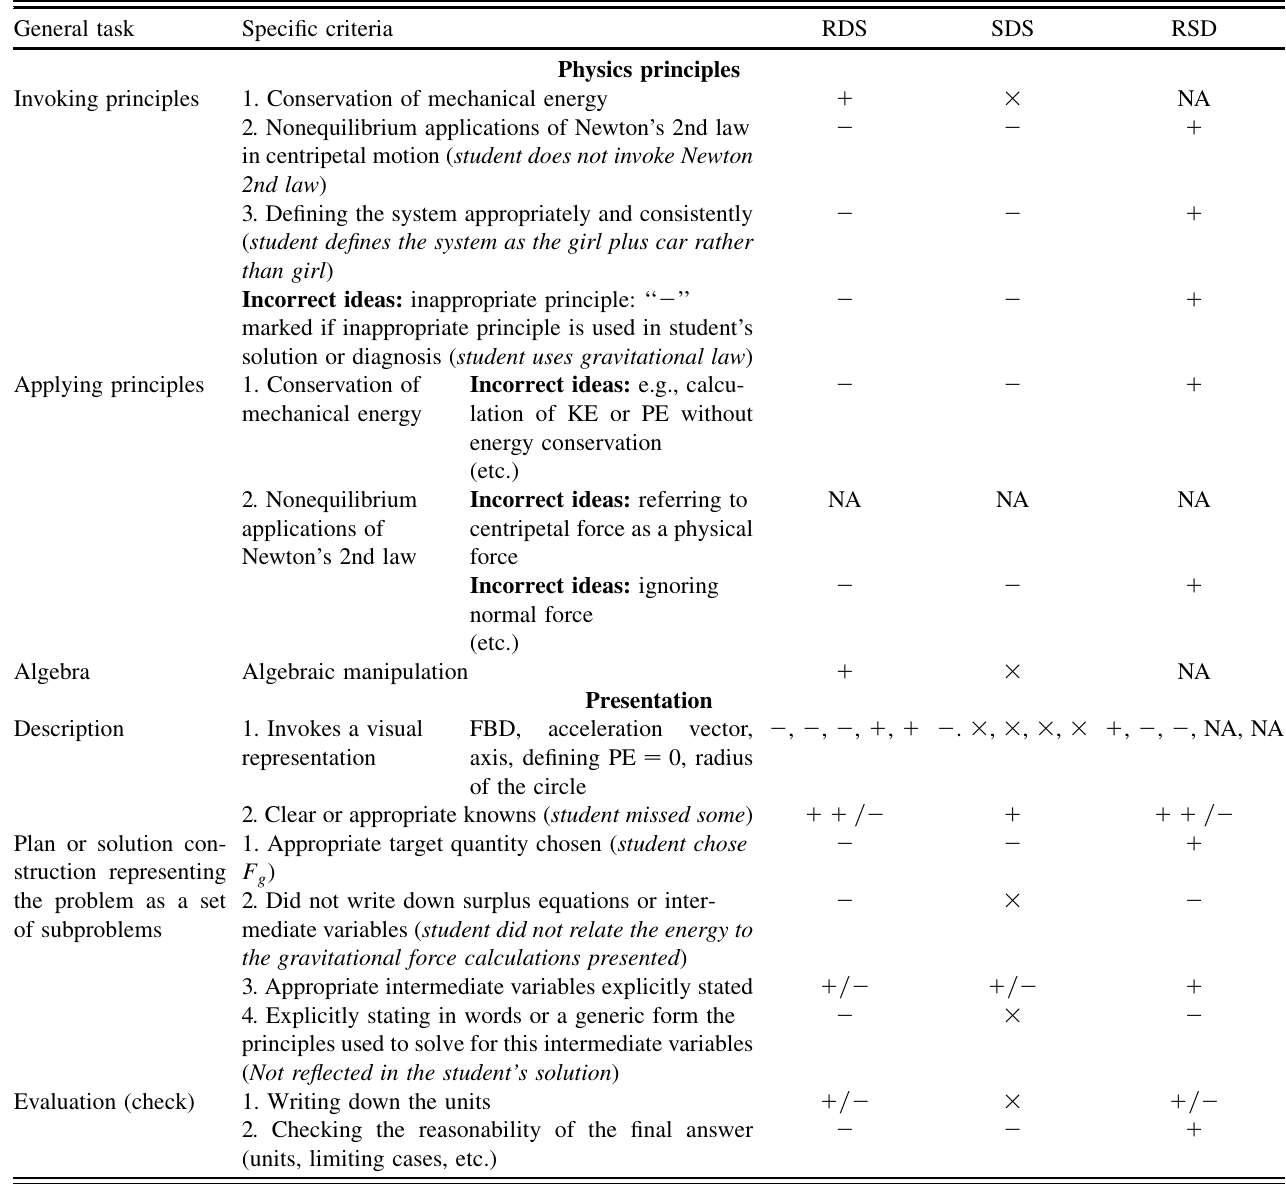
TABLE IV. Self-diagnosis grading rubric adapted to pre problem. In italics, grading of an individual student from group B (Fig. 6). The last three column respectively refer to a researcher diagnosis of student’s solution (RDS), student’s self-diagnosis of solution (SDS), researcher’s assessment of student’s self-diagnosis (RSD). (NA indicates an item being not applicable.) General